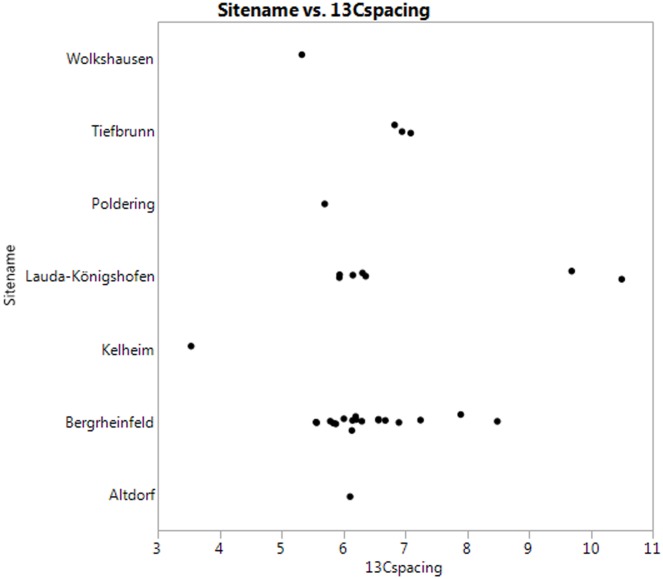
δ13C spacing by site.